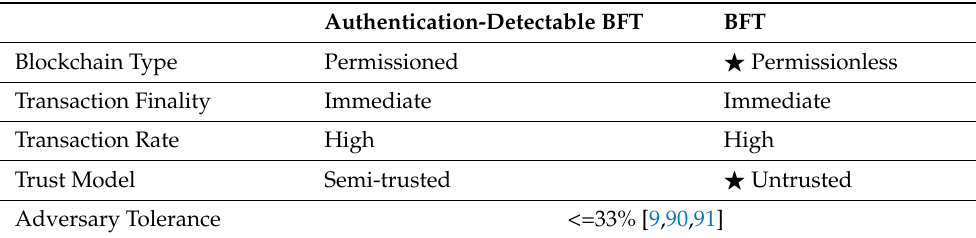
Table 2. Comparing authentication-detectable BFT and BFT consensus